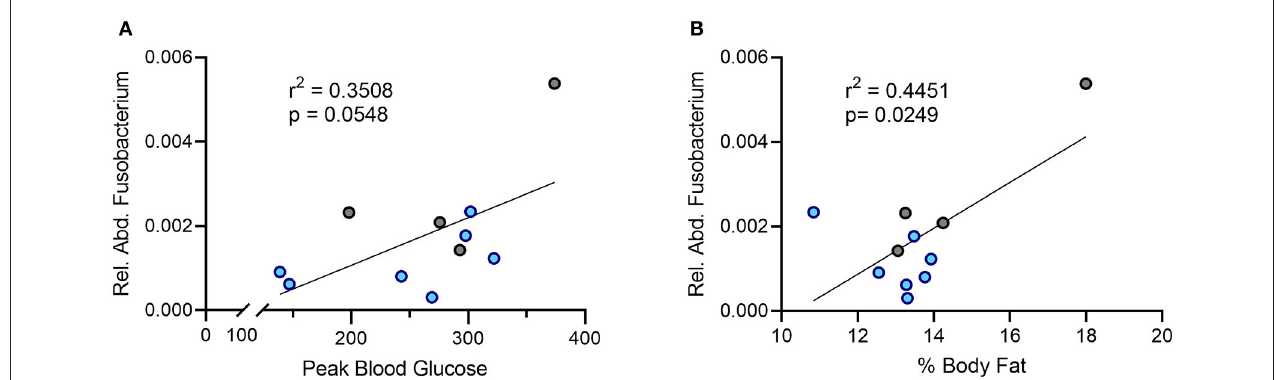
FIGURE 4 | There is a positive correlation between the relative abundance of Fusobacterium and both peak blood glucose and percent body fat. (A) Peak blood glucose is positively correlated with relative abundance of oral Fusobacterium (Pearson’s r = 0.5923; n = 4 WT, 7 DAT T356M + / + ; p = 0.058). (B) The relative abundance of Fusobacterium in the oral cavity and peak blood glucose are positively and significantly correlated (Pearson’s r = 0.6671; n = 4 WT, 7 DAT T356M + / + ; p = 0.0249). Blue dots represent T356M + / + mice and gray dots represent WT